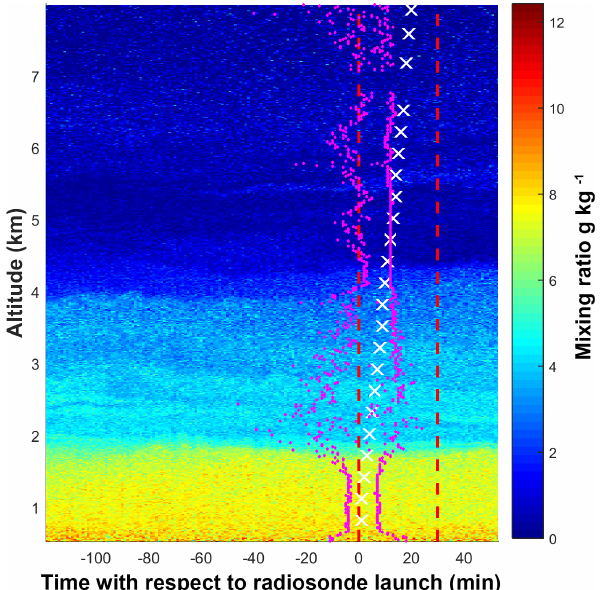
Figure 5. Lidar water vapour mixing ratio measurements on 5 June 2013 at 00:00UTC. The time axis is measured relative to the radiosonde launch. The traditional method uses all scans between the two dashed red lines. The trajectory method uses all measure- ments between the magenta dots. The white “x” markers show the height of the radiosonde with